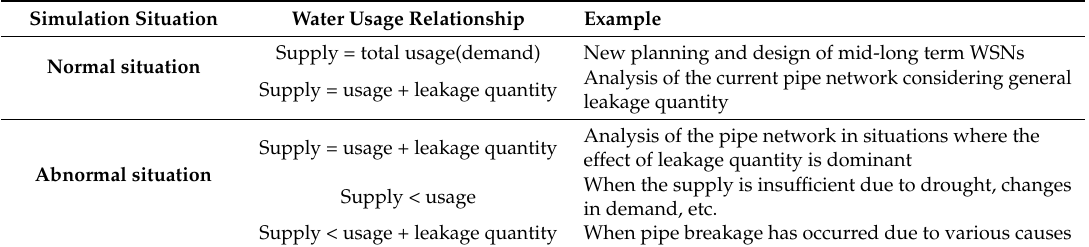
Table 1. Pipe network analysis simulation situations based on water usage relationships (Yoo et al.